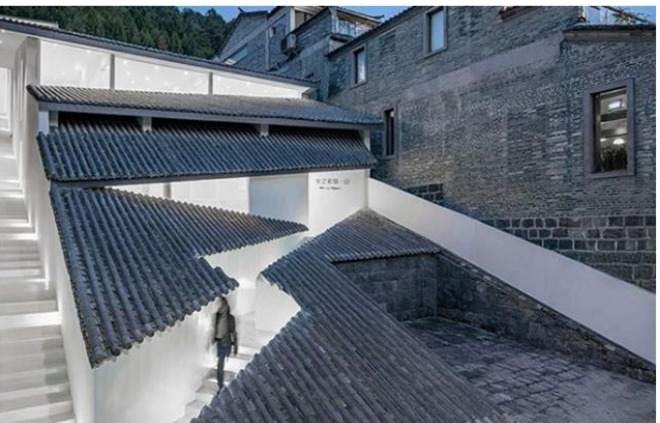
Figure 27. The cover for the conference proceedings Research by Design (source: [53]).